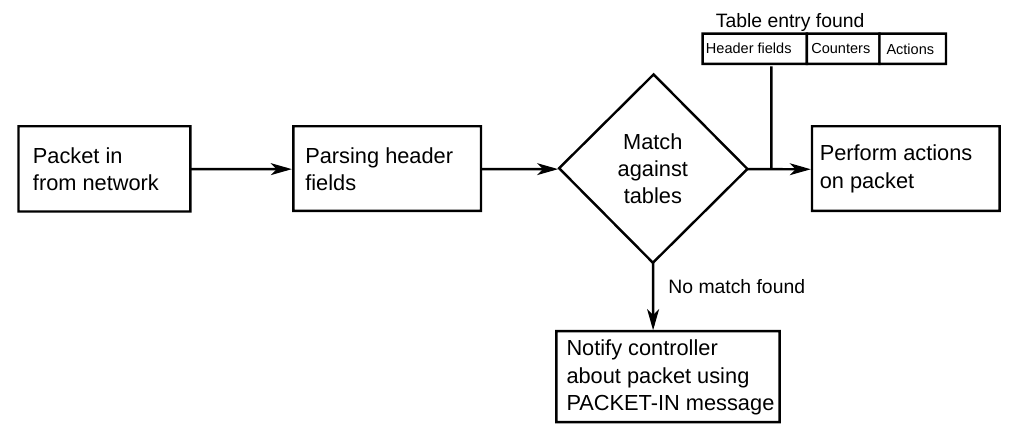
Figure 3. Basic packet forwarding with OpenFlow in a